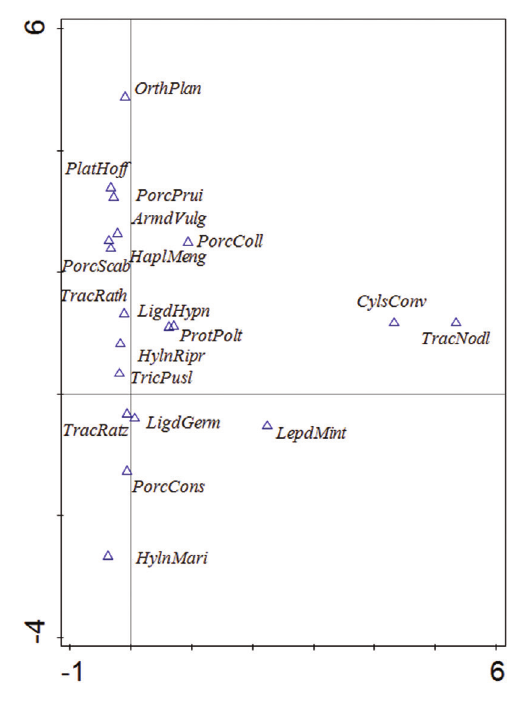
Figure 2. The ordination analysis of isopod species recorded at individual study localities in the White Carpathians (CANOCO 5, unconstrained analysis, DCA). For abbreviation of species’ names, see Table